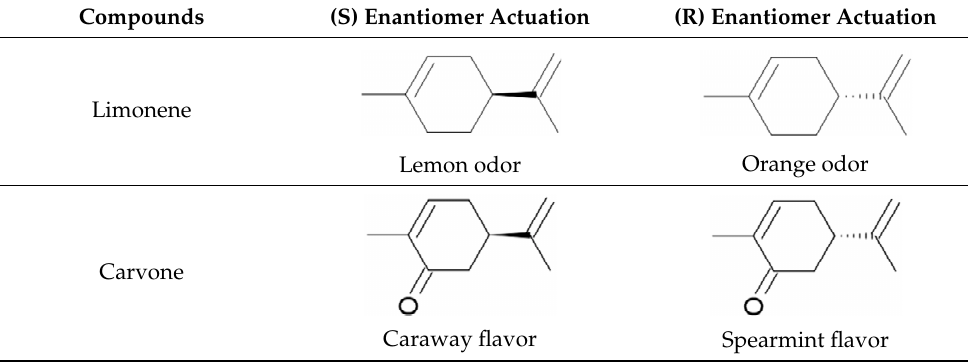
Figure 6. Deoxyribose ( a ) and ribose ( b ) monosaccharides structural formulas from DNA and RNA and their chiral carbons. Table 3. Difference in biological activities between enantiomers [4].